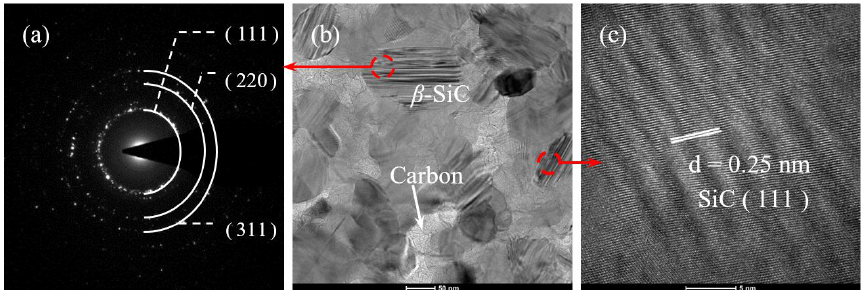
Figure 10. ( a ) SAD pattern and ( b , c ) TEM images of polycrystalline Si-Al-C-O fiber fabricated using the controlled pyrolysis condition.